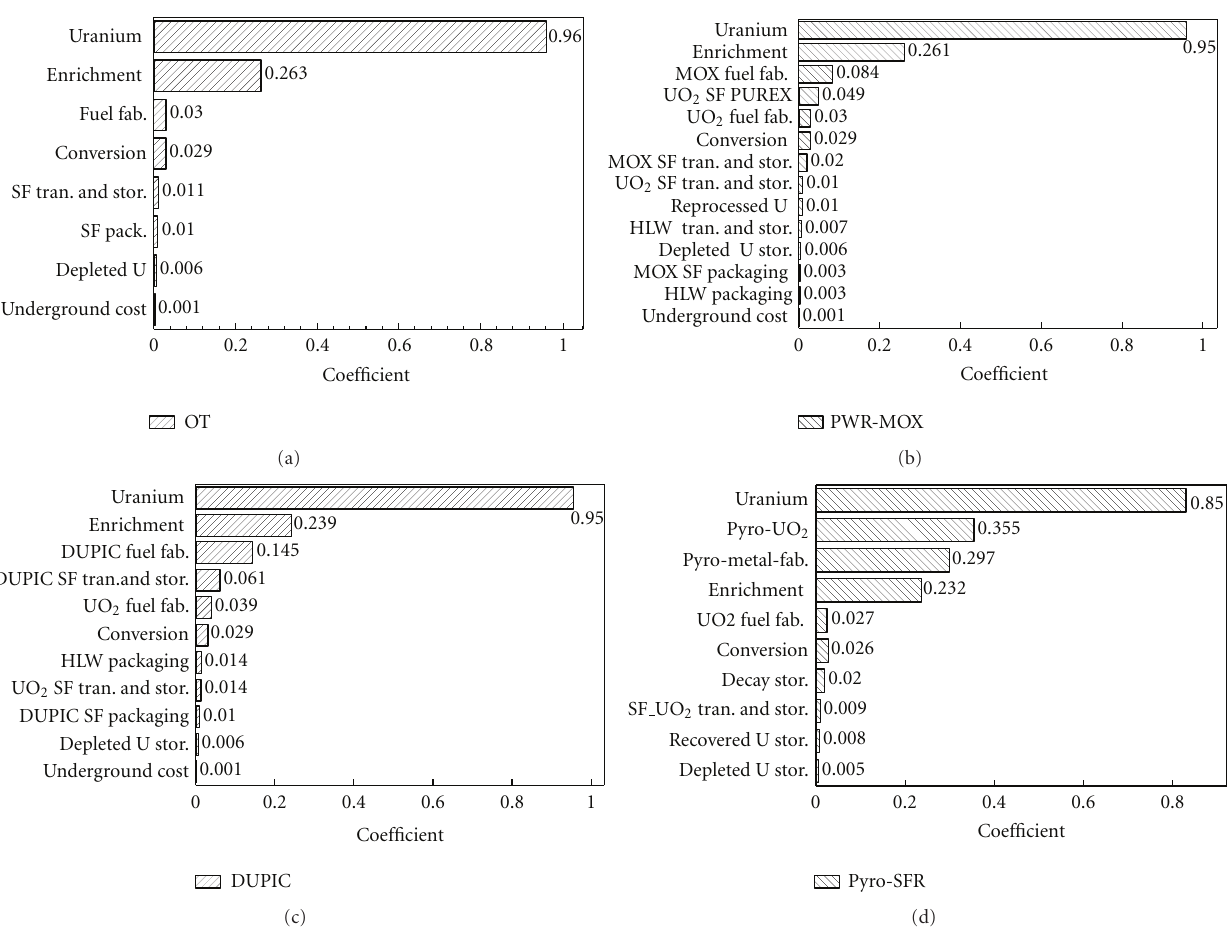
Figure 6: Sensitivity coe ffi cient of fuel cycle